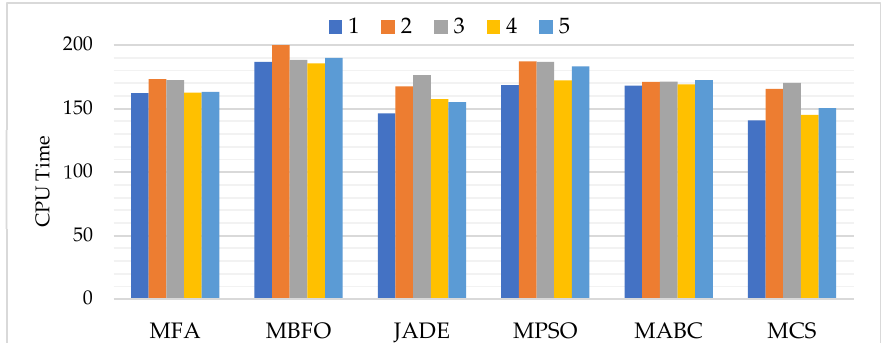
Figure 2. CPU time for different optimization algorithms with EC-Otsu. Table 2. CPU time using different optimization algorithms with the EC-Otsu and MCE entropy methods.